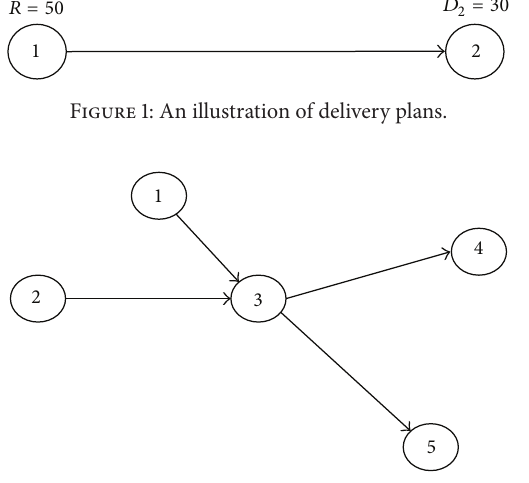
Figure 2: An illustration of a simple transportation network.